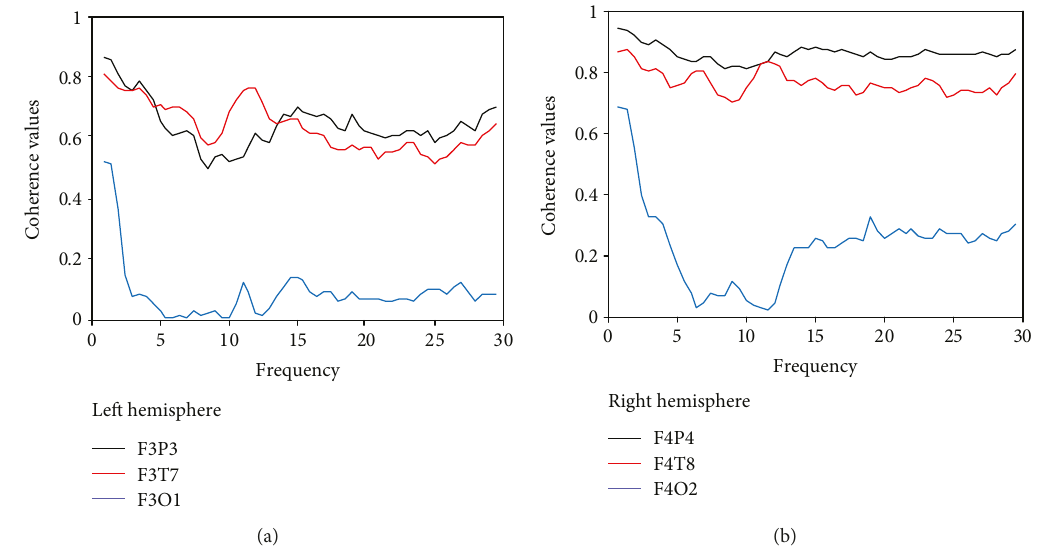
Figure 1: The grand average of evoked coherence during deception. (a) The grand average of evoked coherence for the F3P3, F3T7, and F3O1 electrode pairs in the left hemisphere. (b) The grand average of evoked coherence for the F4P4, F4T8, and F4O2 electrode pairs in the right hemisphere.